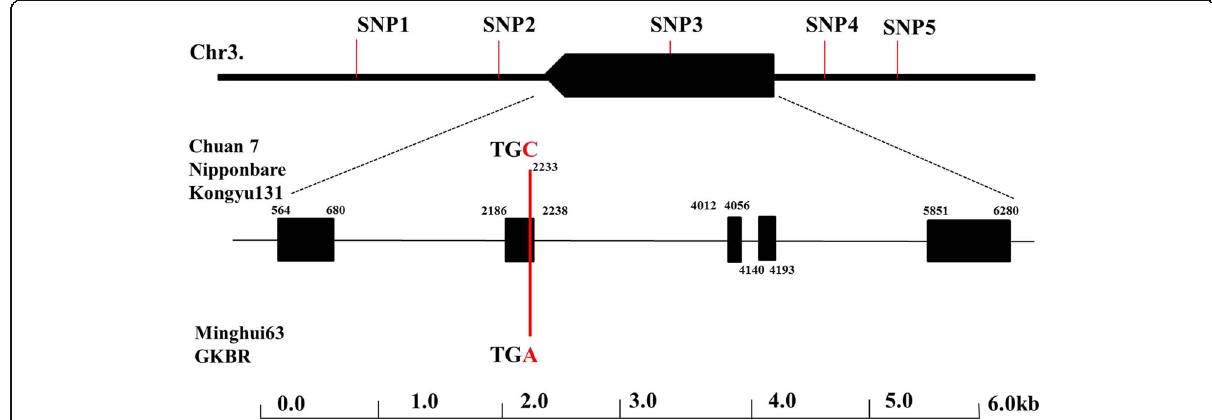
Fig. 2 GS3 sequence comparison and SNP markers used to select for gs3 . Kongyu 131 and GKBR has a base variance with the red indicates at the second exon as same as difference between Chuan 7 and Minghui 63 from which the GS3 gene was first cloned